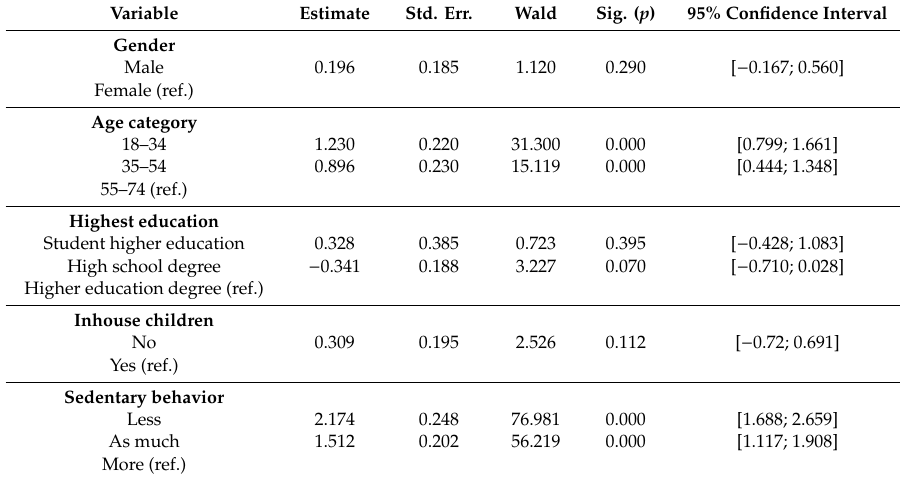
Table 4. Output ordinal logistic regression analysis of demographic determinants on exercising less, as much, or more (subsample low active people, n = 1752). Variable Estimate Std.